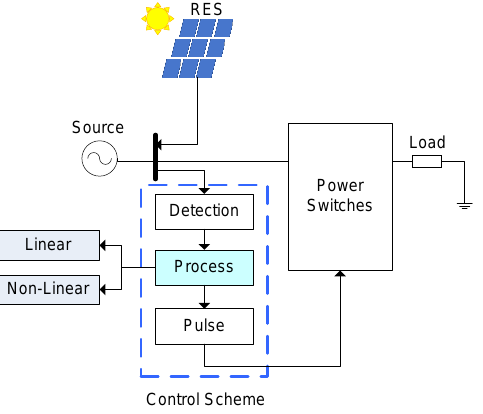
Figure 9. Block representation of the control scheme inside a power quality compensation device.